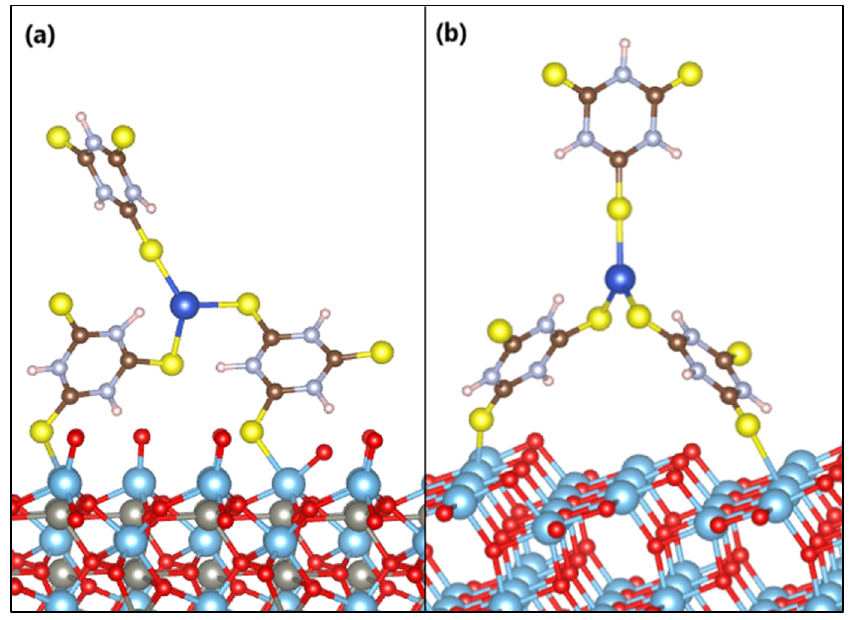
Figure 12. Anchoring modes of the s -Cu-TTC molecule on the surface of ( a ) ZnTiO 3 and ( b ) TiO 2 .